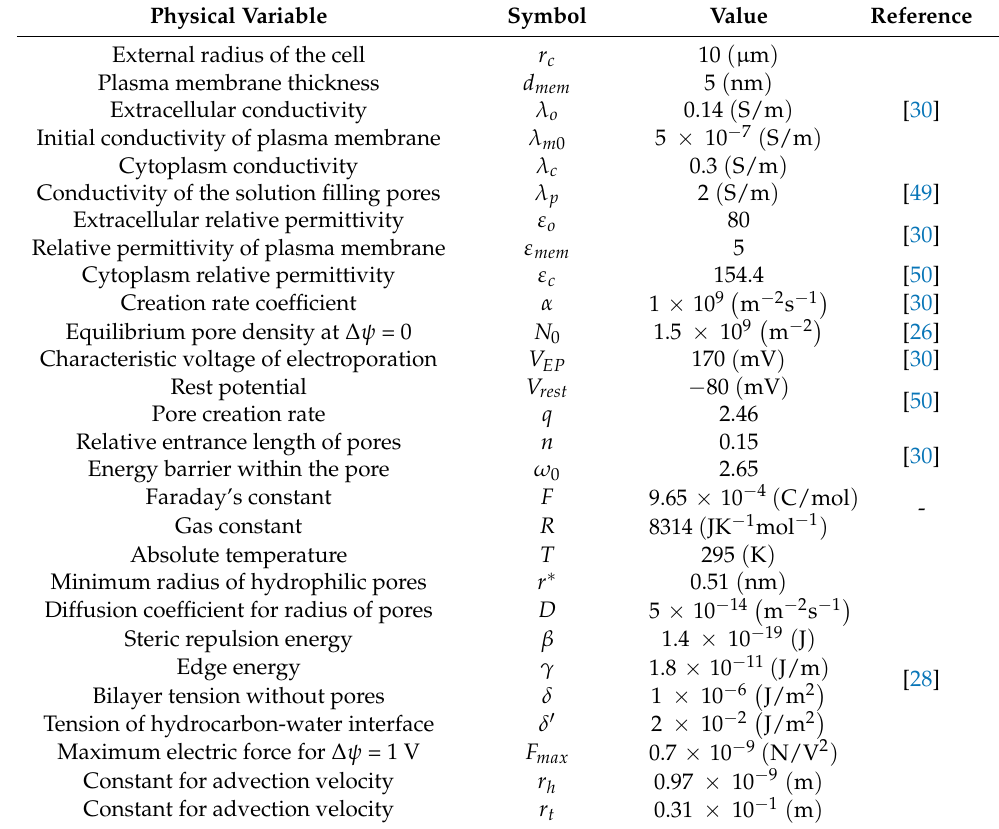
Table 1. Physical variables used in the SCE model.